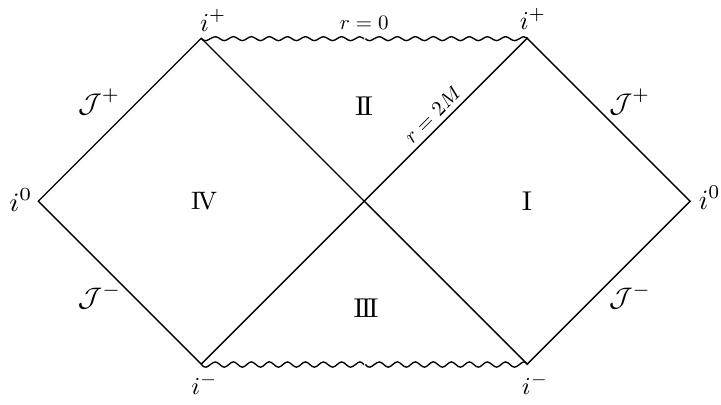
Figure 1 . The Penrose diagram of maximally extended Schwarzschild spacetime. Region I and II are the outside and the inside of the event horizon respectively, and region III is the white hole interior. Region IV is the mirror domain of region I. Physically relevant regions to a BH formed by gravitational collapse are Region I and